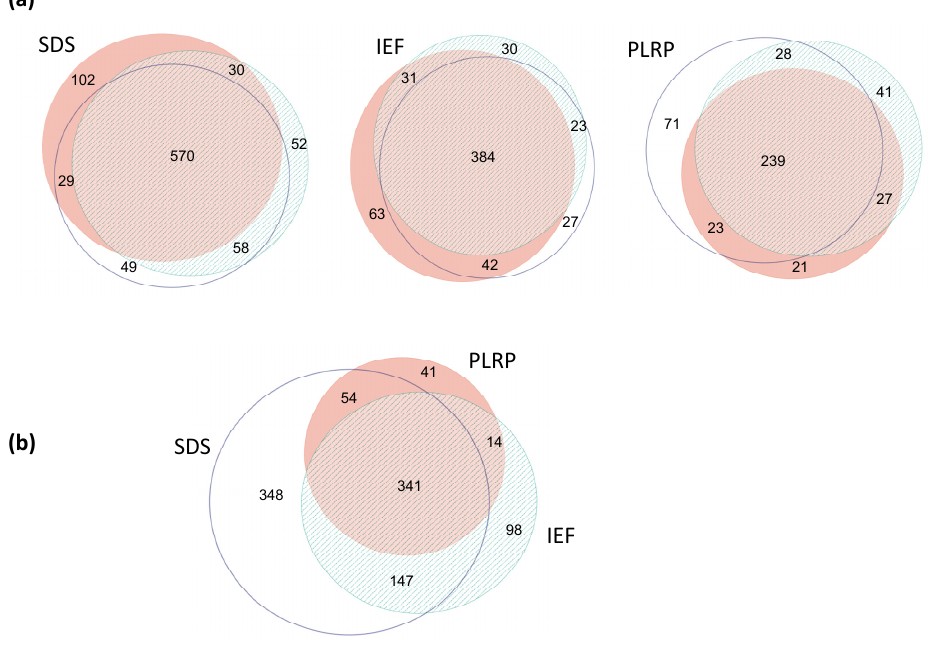
Figure 2. Venn diagrams showing distribution of unique proteins identified by each platform. ( a ) Top portion of the figure shows the overlap for each platform among the three technical replicates; ( b ) Bottom portion of the figure shows the overlap between the three individual